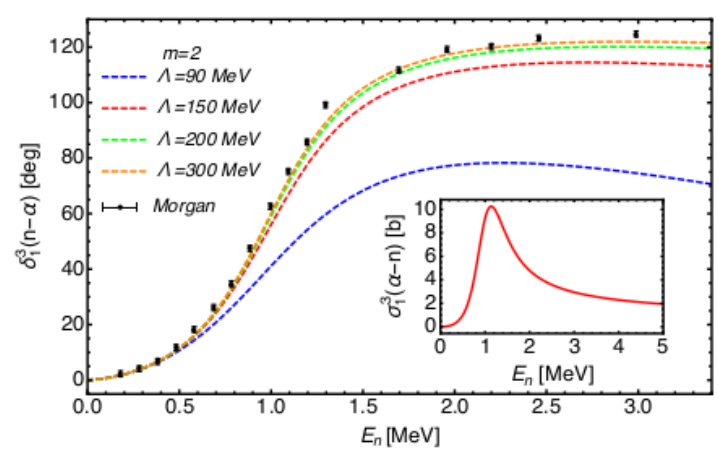
Figure 1: Phase shifts δ and Walter [ 14 ] and in the inset the cross-section σ